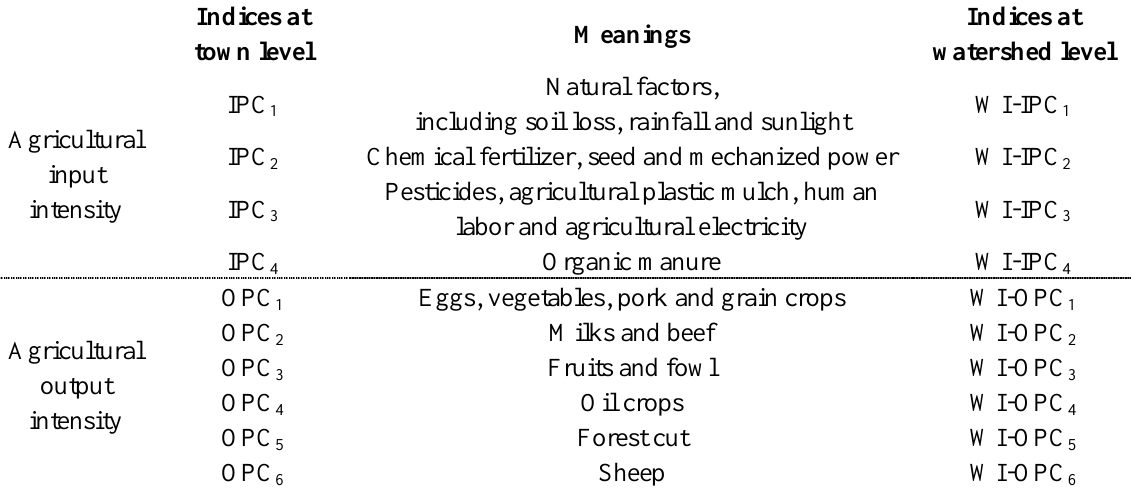
Table 6. The indices of agricultural input and output